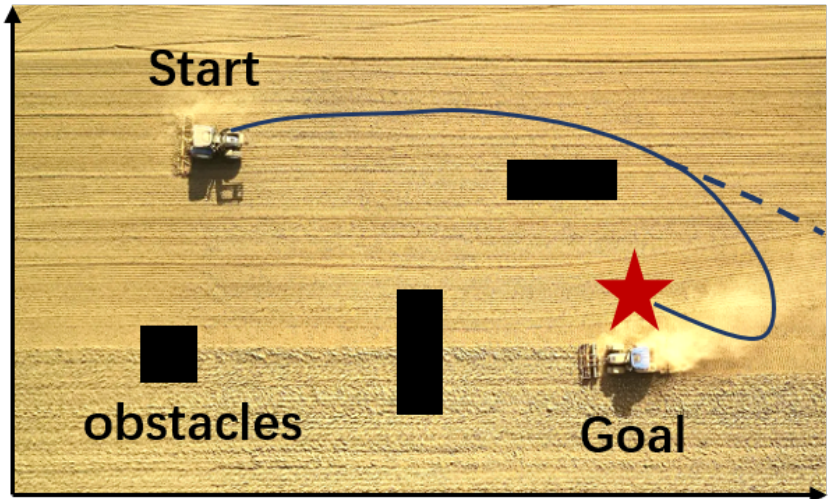
Figure 6. The drawback existed in the training process. If the agent misses the goal point, it is difficult to adjust the action to turn to the correct